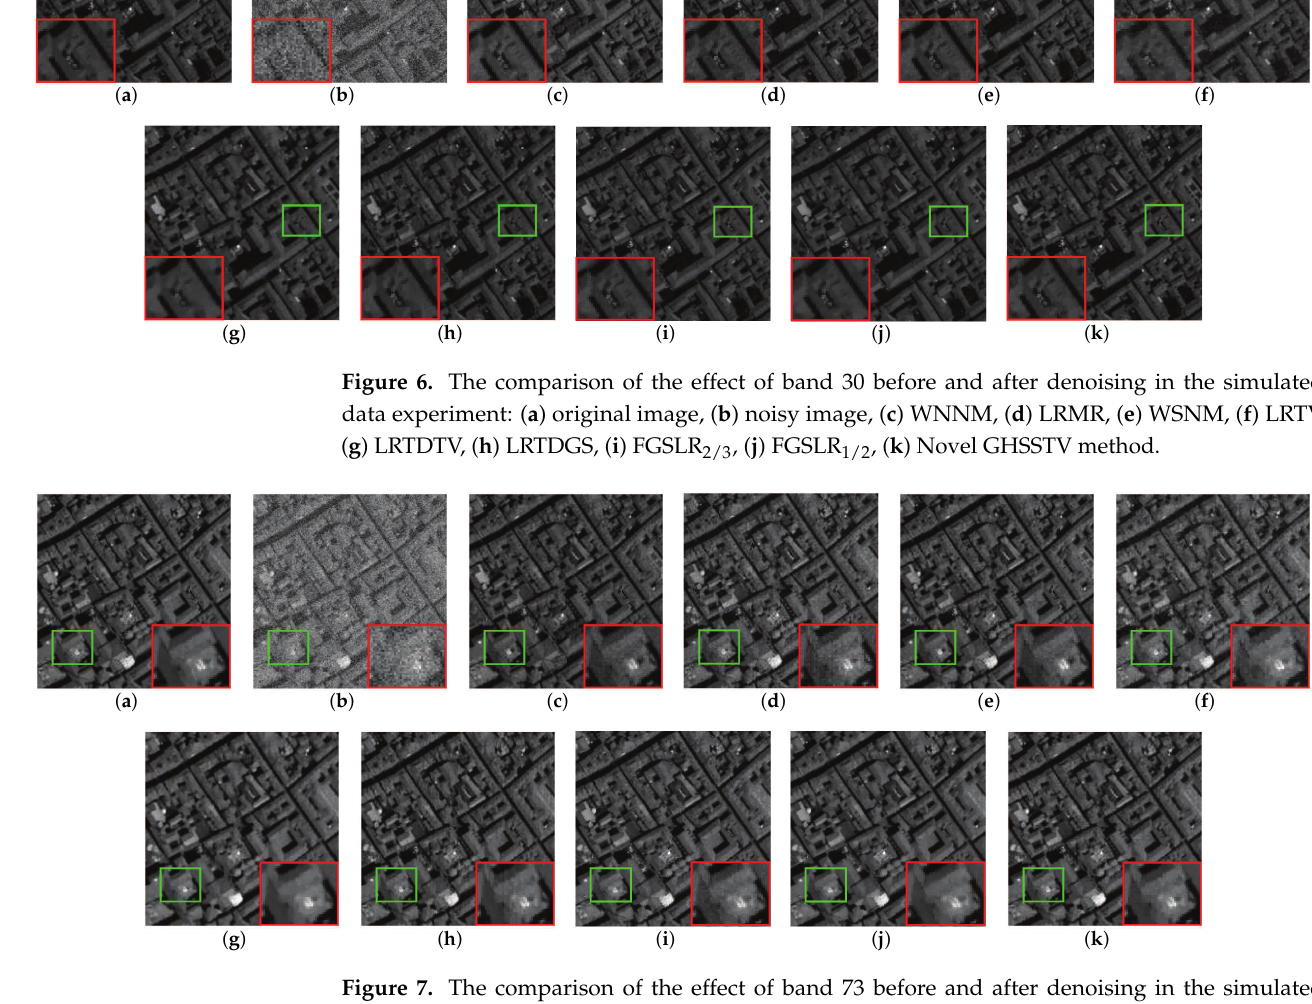
Figure 7. The comparison of the effect of band 73 before and after denoising in the simulated data experiment: ( a ) original image, ( b ) noisy image, ( c ) WNNM, ( d ) LRMR, ( e ) WSNM, ( f )